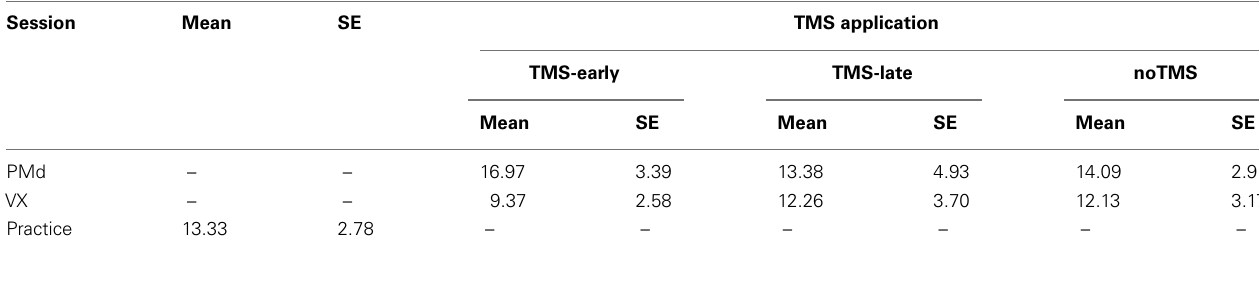
Table 1 | Mean error rates (%) and SE forTMS (TMS-early,TMS-late), and noTMS trials for the twoTMS sessions (PMd andVX) and for the practice